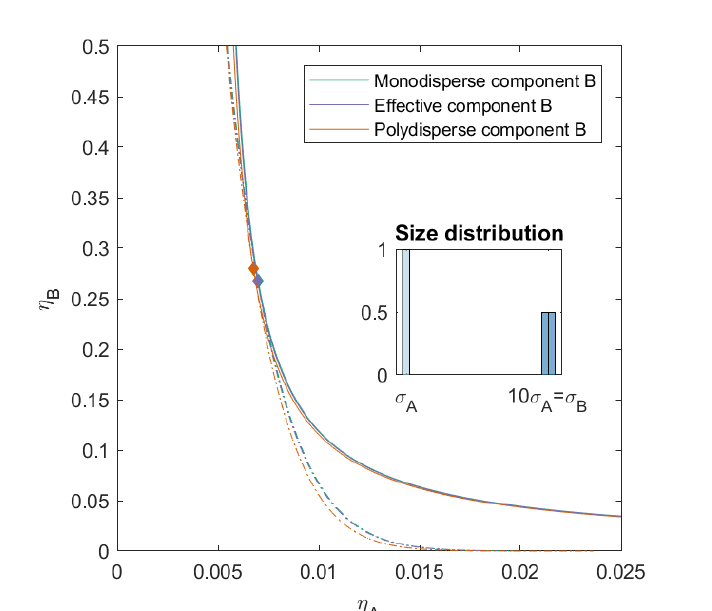
Figure 3. Phase diagram for binary (component A and B ) additive hard sphere mixture with size ratio q = σ A / σ B = 1/10, component A is monodisperse, component B is polydisperse (see size distribution, ( PD = 4.00)), with a number average size 10 times the size of component A , plotted as a function of the partial packing fractions, η A and η B . The spinodal ( solid line ) and binodal ( dashed line ) meet each other at the critical point (diamond).